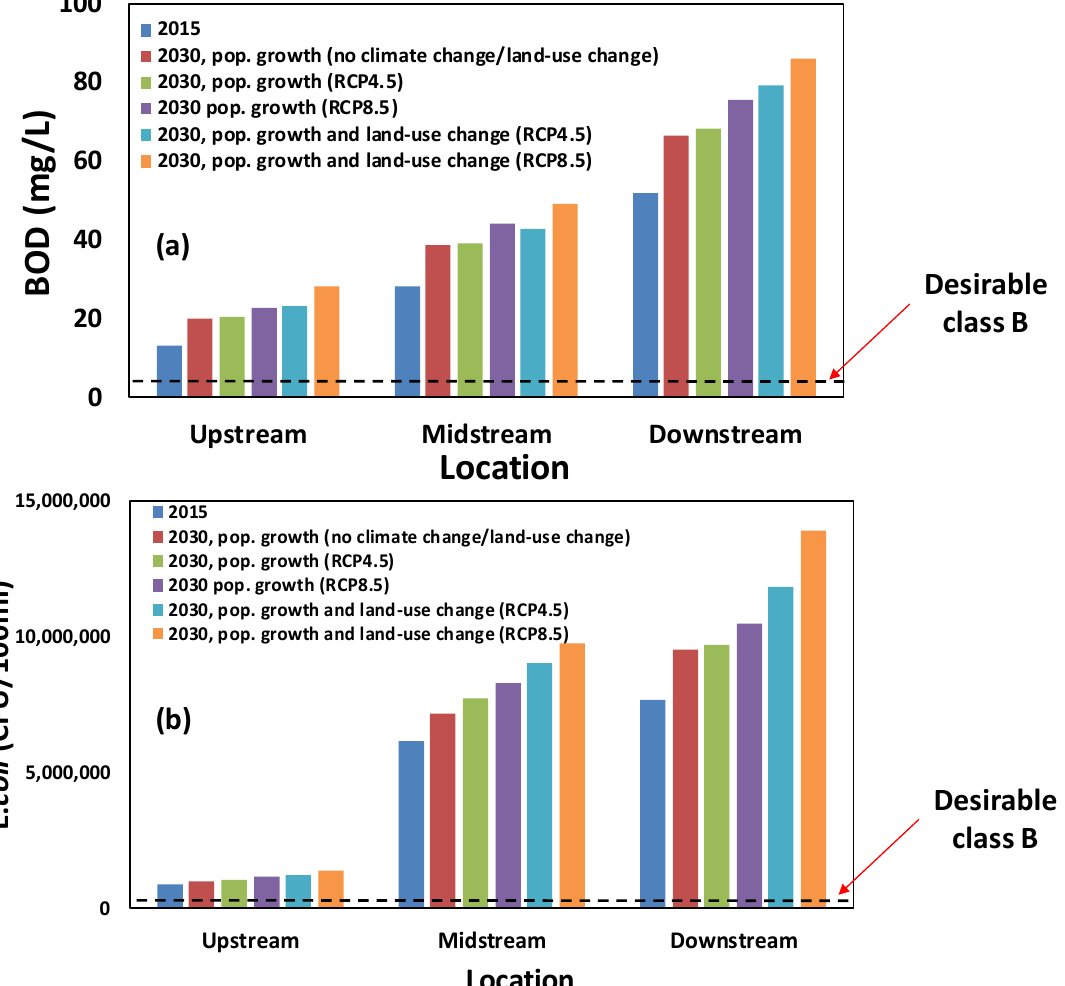
Figure 8. Result shows simulated water quality parameters ( a ) BOD ( b ) E. coli for future scenario without adaptation measures.